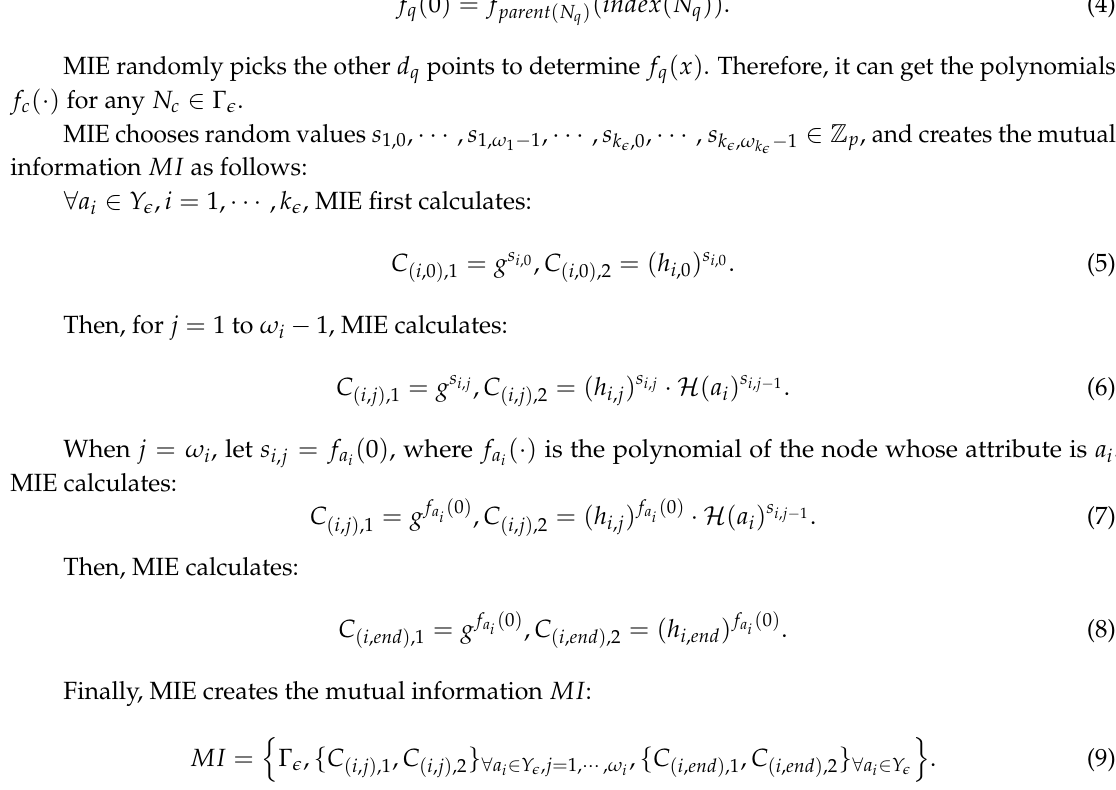
Algorithm 1 shows the pseudocode of the MutualInfoGen algorithm. Algorithm 1 The mutual information generation algorithm ( MutualInfoGen